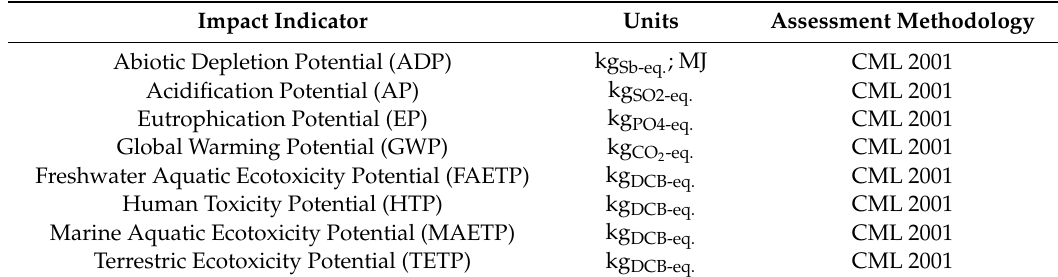
Table 4. Environmental indicators, units and assessment